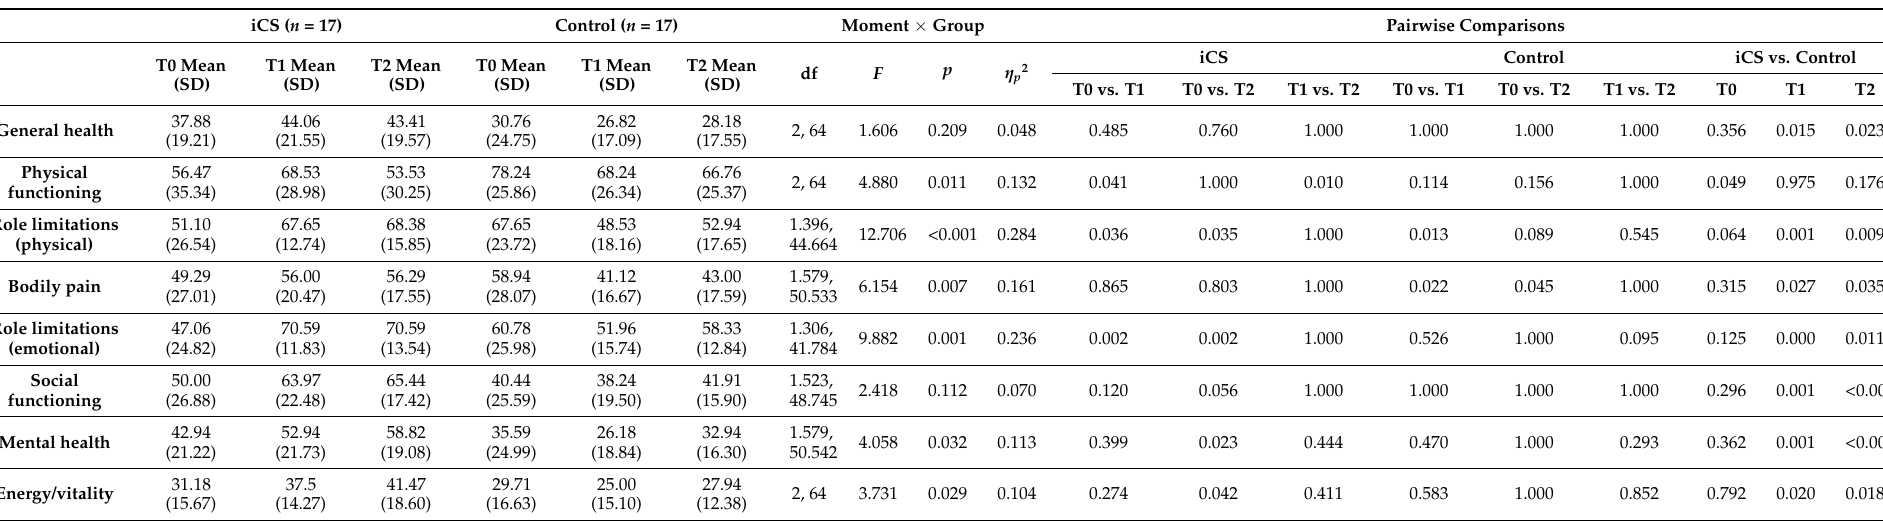
Table 4. Results of the repeated-measures ANOVA for the SF-36v2 domain scores. Results of pairwise comparisons (Bonferroni correction) for iCS vs. the control group at baseline (T0), endpoint (T1), and follow-up (T2) assessments. The results of the pairwise comparisons (Bonferroni correction) for iCS and control groups are also given (T0 vs. T1, T0 vs. T2, and T1 vs.